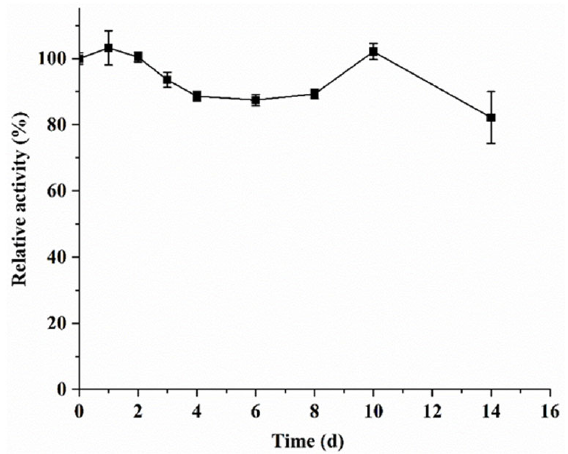
Figure 6. Storage stability of KsLX3-SIase. Data are the means ± SD from triplicate samples. The time-course reaction catalyzed by KsLX3-SIase produced in B. subtilis was investi- gated by employing various sucrose concentrations. As depicted in Figure 7, the maximum yields of isomaltulose were 84.2 ± 0.3%, 84.2 ± 1.4%, and 87.8 ± 0.3% when the sucrose concentrations used were 80 g/L, 120 g/L, and 160 g/L, respectively, demonstrating that a sucrose concentration. In addition, the rate of isomaltulose yield was rapid during